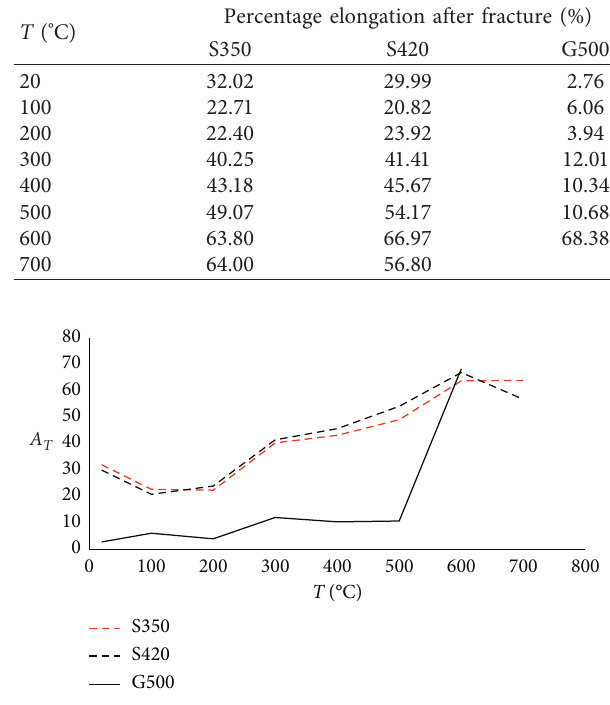
Figure 12: Average percentage elongation after fracture at different